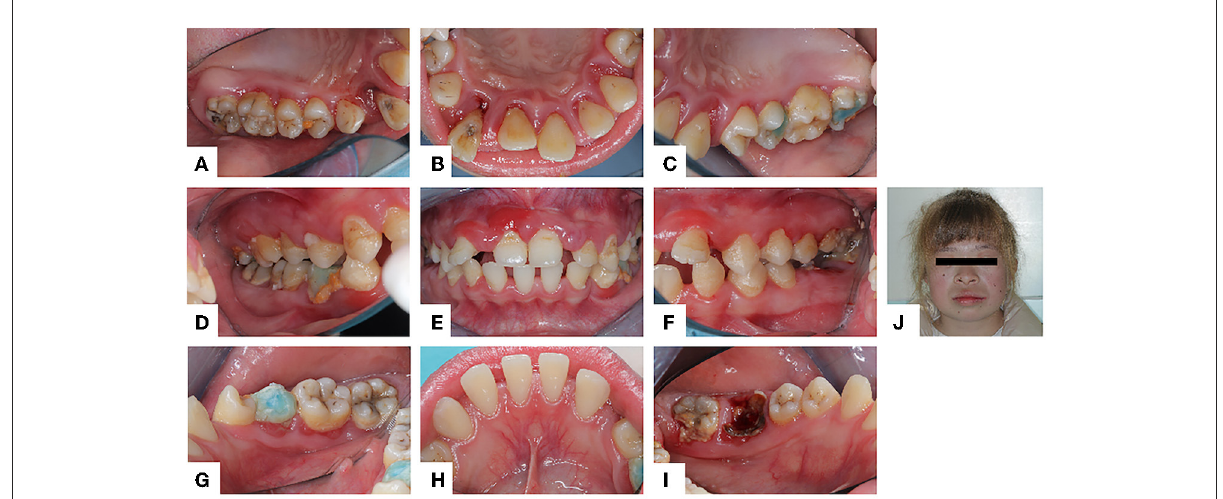
FIGURE1 Intraoral and facial photo (July 12, 2021): (A–I) The gums were extensively red and swollen. Abduction and displacement of maxillary anterior teeth. (J) The proband has blonde hair and whole-body skin whiteness.